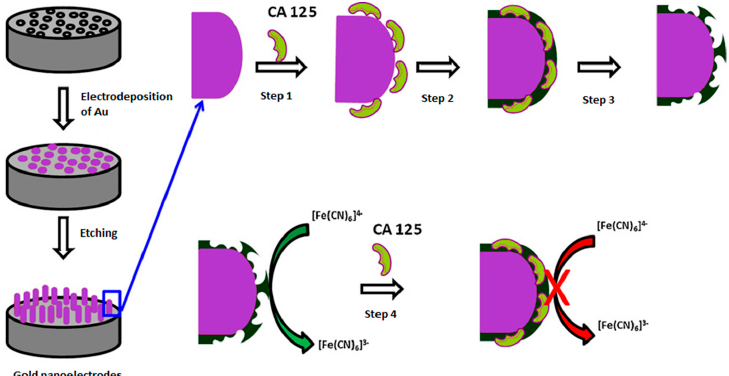
Figure 3. Schematic representation of molecular imprinted protein nanosensor fabrication and template protein detection. Step 1: adsorption of CA-125 onto the nanoelectrode surface; Step 2: electrochemical polymerization of phenol; Step 3: template protein removal; Step 4: CA-125 binding and signal generation. Adapted with permission of [42]. ©2012 Elsevier.